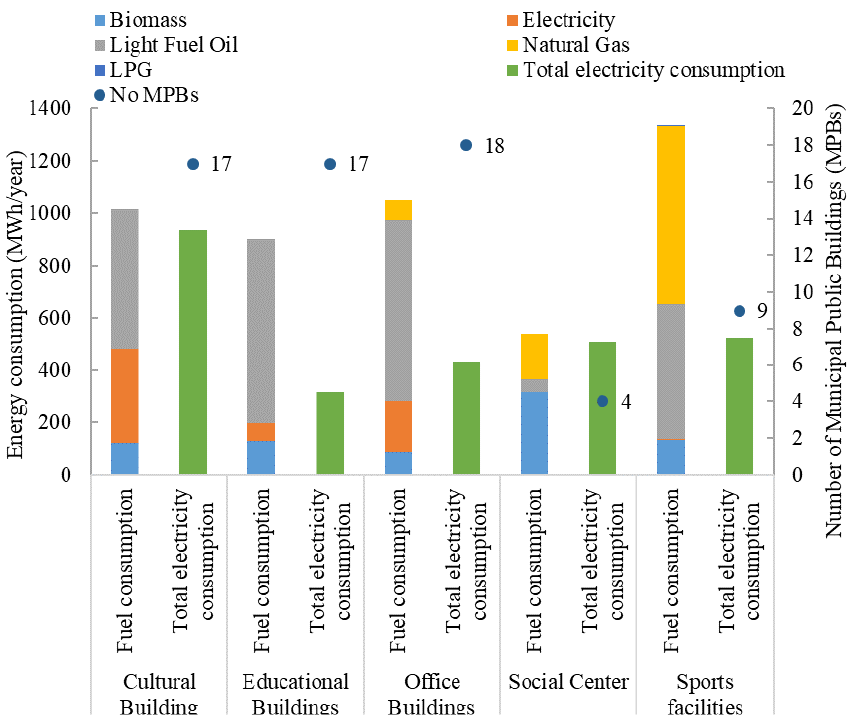
Figure 7. Aggregated fuel consumption and total electricity consumption of the different buildings typologies assessed in this work. typologies assessed in this